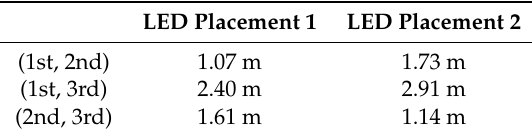
Table 2. Distance of each LED